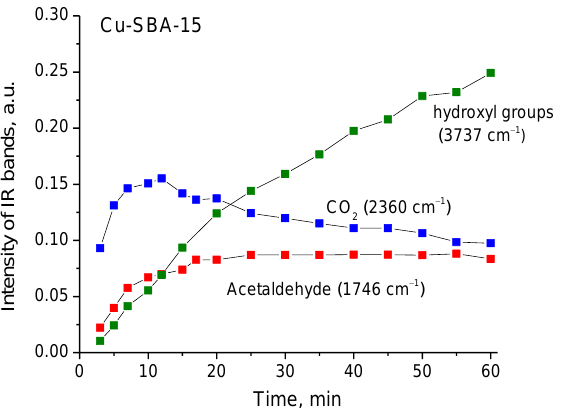
Figure 10. Changes in the intensity of IR bands in the spectra recorded for Cu-SBA-15 catalyst in ethanol and oxygen flow at 473 K during 60 min: acetaldehyde (red), CO 2 (blue), and consumption of hydroxyl groups (green).